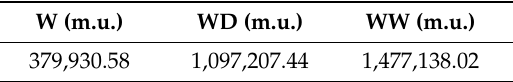
Table 10. Remuneration